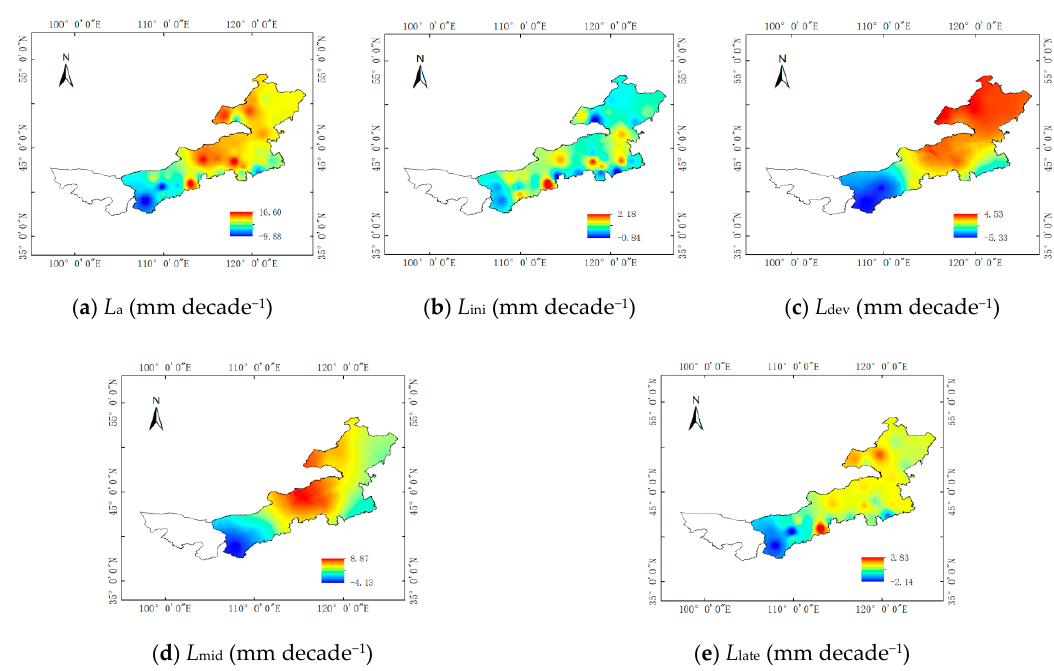
Figure 6. Spatial variation characteristics of ET c slope during the entire growth period ( a ), early growth period ( b ), rapid growth period( c ), middle growth period ( d ), and end growth period ( e ) of maize from 1959 to 2018.